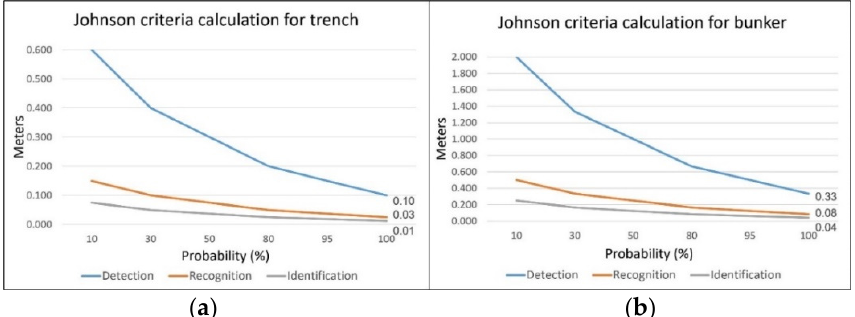
Figure 15. GDS size for the detection, recognition and identification of ( a ) a trench and ( b ) a bunker. Both diagrams show the GSD values for 100% detection, recognition and identification of the objects on the image. Table 3. Some examples of radiometric characteristics, theoretical GSD of selected images with indicators of mine presence, cameras with which the images were collected and the subjective confidence of the human image interpreter in his findings.